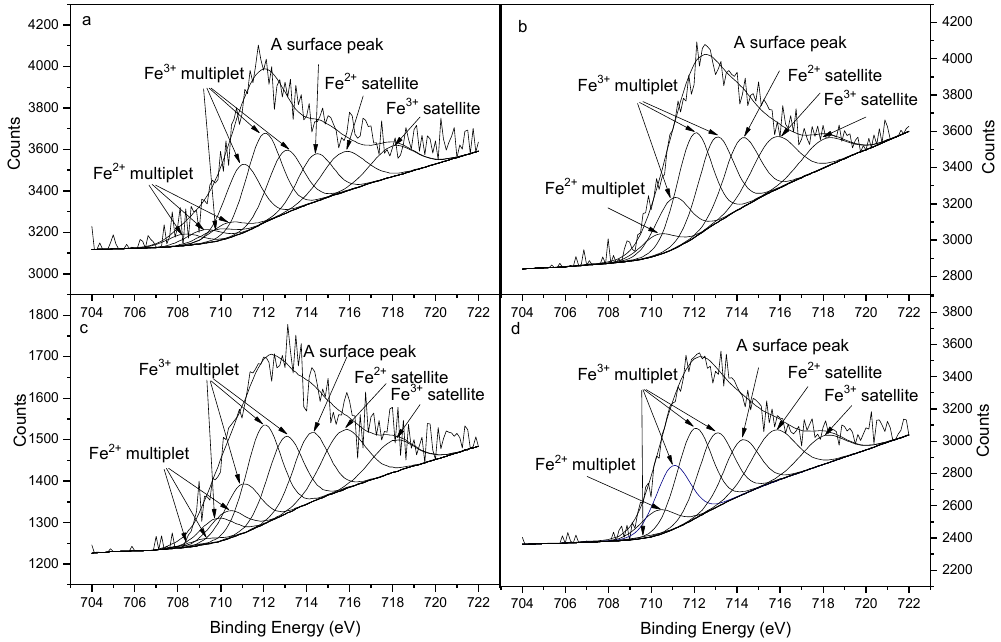
Figure 6. Fe (2p 3/2 ) XPS fitting curves of SBB before and after phosphate adsorptions. ( a ) Fe (2p 3/2 ) XPS fitting curves of SBB; ( b ) Fe (2p 3/2 ) XPS fitting curves of KDP-adsorbed SBB; ( c ) Fe (2p 3/2 ) XPS fitting curves of STPP-adsorbed SBB; ( d ) Fe (2p 3/2 ) XPS fitting curves of SGP-adsorbed SBB. Table 5. Relative contents of Fe(II) and Fe(III) multiple peaks in Fe (2p 3/2 ) XPS fitting curves (Percent of total peak area, %) and Fe(III) to Fe total surface ratio.